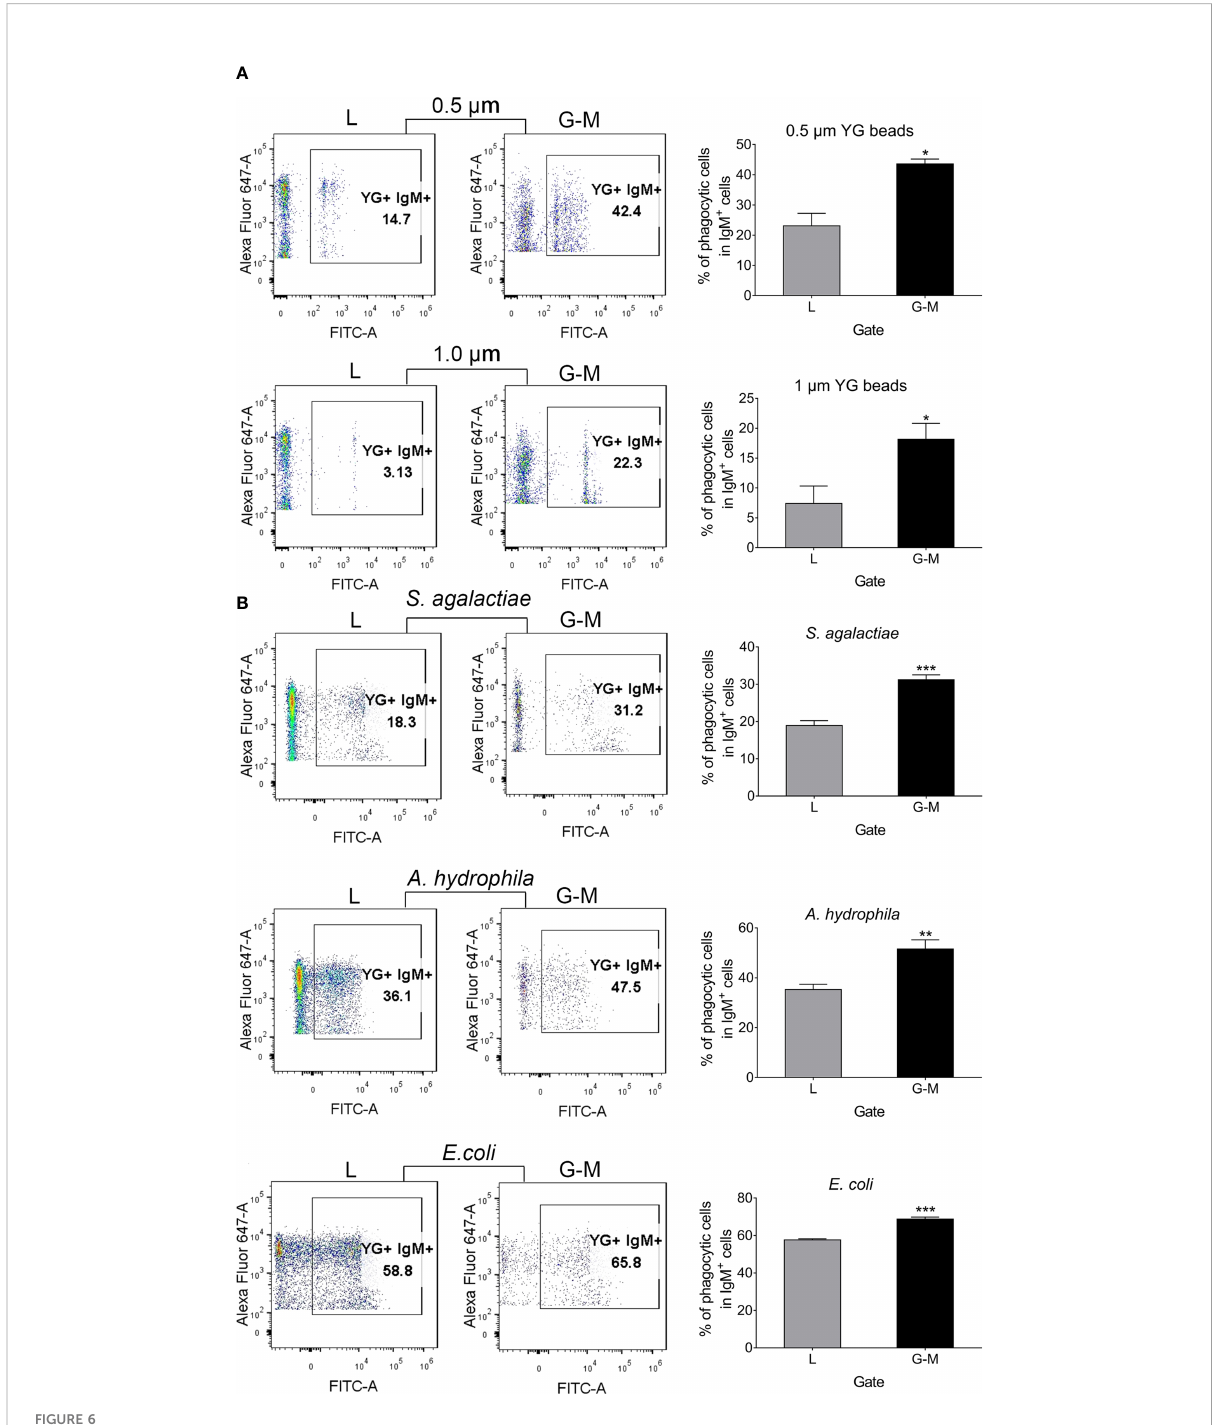
FIGURE 6 Tilapia L-gate IgM + and G-M gate IgM + cell phagocytosis of fl uorescent beads (0.5 µm and 1.0 µm in diameter) and different pathogens (including S. agalactiae , A. hydrophila , and E. coli . (A) For the phagocytosis of beads, leukocytes from anterior kidney (AK) were incubated with 0.5-µm- and 1.0-µm-diameter fl uorescent beads in a 1 : 10 (cell – bead) ratio. (B) For the pathogens, leukocytes from AK were incubated with inactivated S. agalactiae , A. hydrophila , and E. coli labeled with fl uorescein isothiocyanate (FITC); the cell-to-pathogen ratio was 1 : 100. After 3 h, cells were dyed with Alexa Fluor ™ (AF) 647-labeled mouse anti-IgM mAb for 30 min, and were then washed three times with Roswell Park Memorial Institute (RPMI)-1640 medium at 4°C for 5 min. Cells were detected with a BD FACSAria ™ III fl ow cytometer and analyzed with FlowJo V10 software. Scatterplots and the statistical results (phagocytic IgM + cells as a percentage of total IgM + cells in each gate) are shown ( n = 6 fi sh). Asterisks indicate signi fi cant differences (* p ≤ 0.05, ** p ≤ 0.01, and *** p ≤